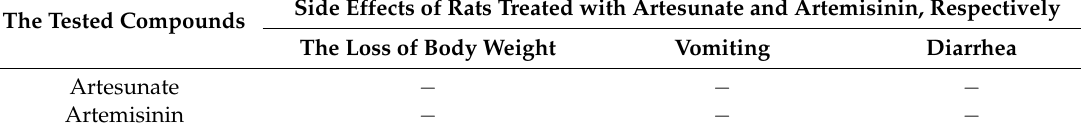
Side Effects of Rats Treated with Artesunate and Artemisinin, The Tested Compounds